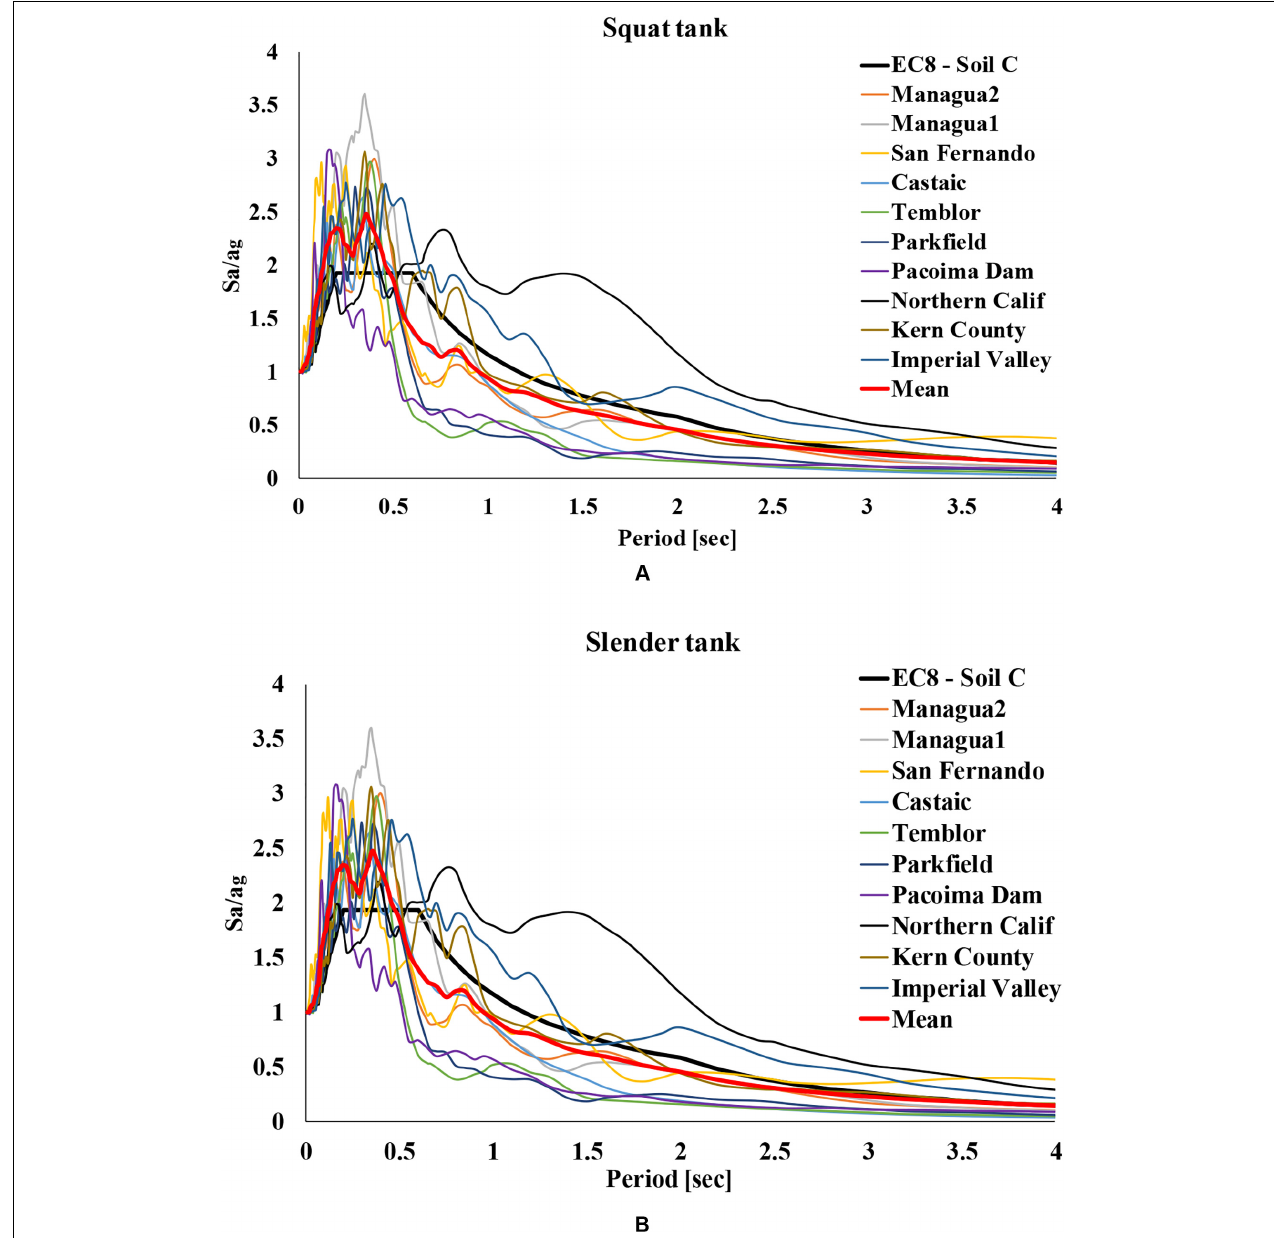
FIGURE 4 | Scaled response spectra for (A) the squat and (B) the slender tank.